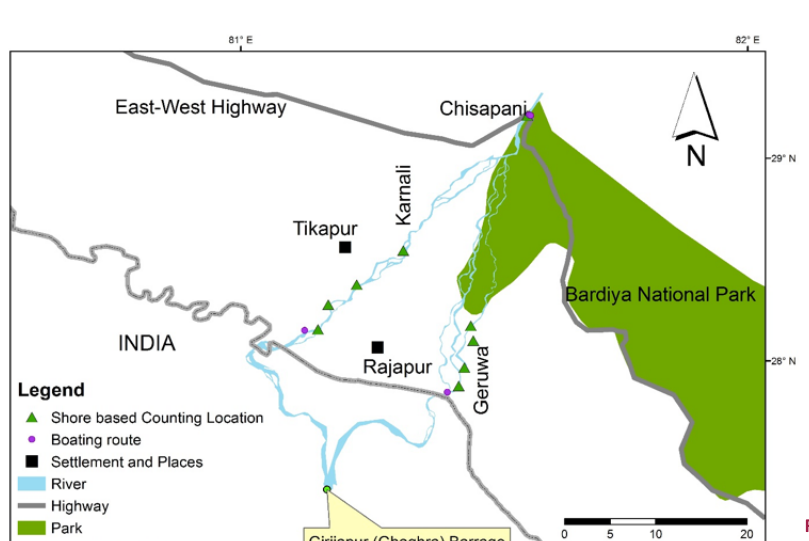
Figure 1. The studied rivers of Nepal namely (from left to right) Mohana, Karnali, Narayani, and Koshi.